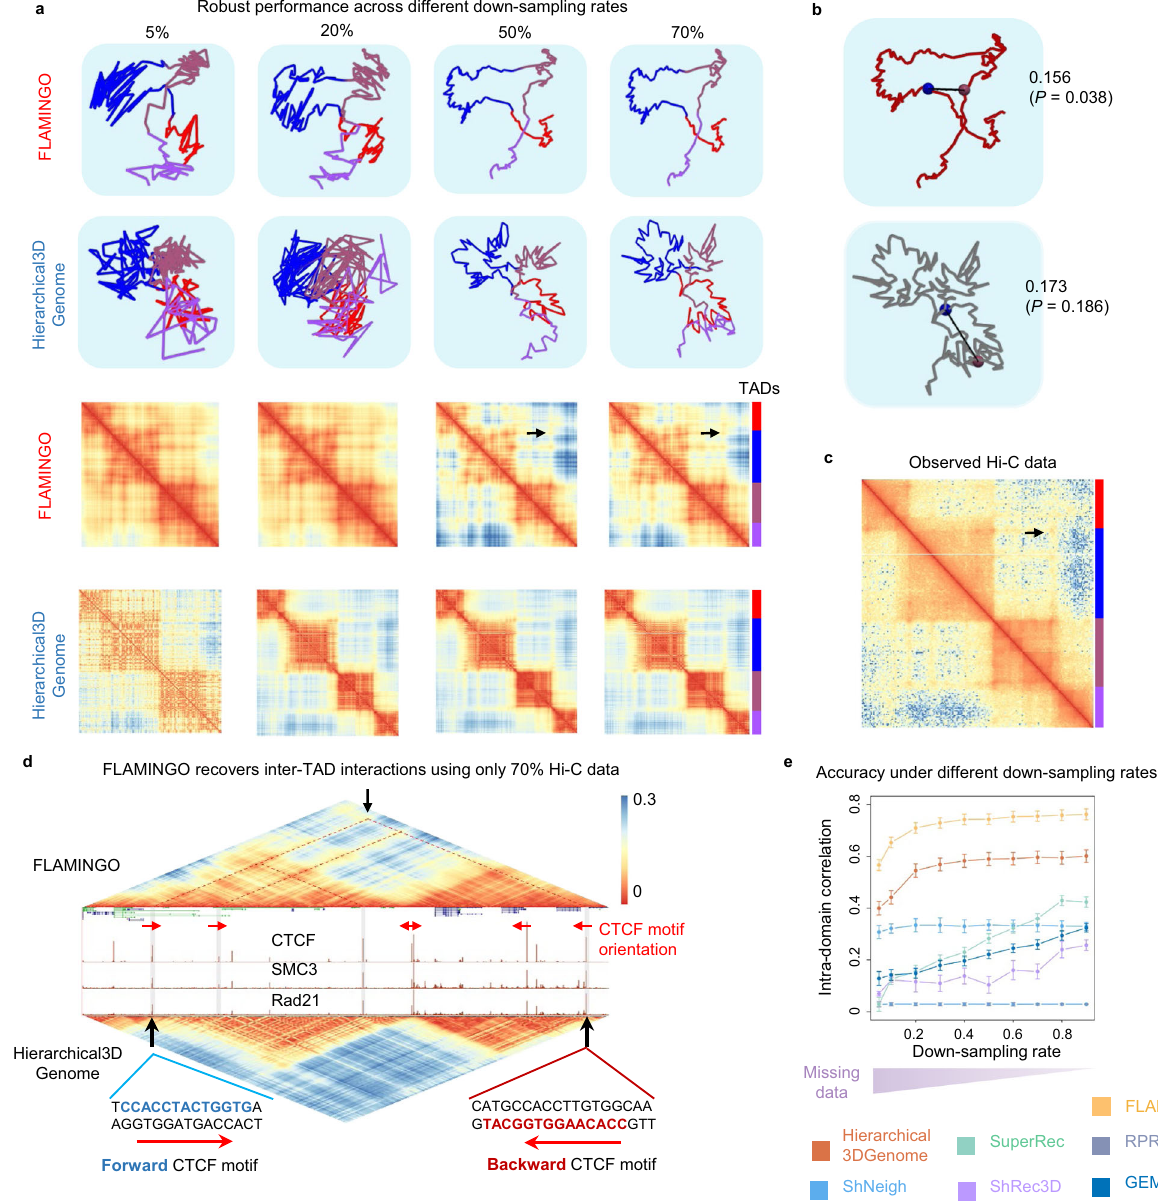
Fig. 6 FLAMINGO robustly reconstructs 3D genome structures under different rates of missing data. a Reconstructed 3D structures and completed distance matrices by FLAMINGO and Hierarchical3DGenome in chr21:34,000,000 – 35,000,000 using down-sampled data. As inputs, the observed distance matrix from Hi-C is down-sampled with different down-sampling rates (columns). Four TADs within this genomic region are annotated by colors. The inter- TAD interaction recovered only by FLAMINGO is highlighted by the black arrow. b FLAMINGO correctly recovers the short 3D distance between the two distal TAD boundaries (5 ’ of the blue TAD and 3 ’ of the brown TAD) as highlighted in a , with 70% down-sampled data. After normalization, FLAMINGO predicts a 3D distance of 0.156 ( p -value = 3.8×10 − 2 , n = 1000, permutation test, genomic distance controlled), while Hierarchical3DGenome predicts 0.173 ( p -value = 0.1862, n = 1000, permutation test, genomic distance controlled). c The observed distance matrix from Hi-C data, along with TAD annotations and the highlighted inter-TAD interaction. d The inter-TAD interactions recovered by FLAMINGO (zoom-in view of the blue and brown TADs within chr21:34,100,000 – 34,850,000) are supported by CTCF and cohesin bindings and the convergent CTCF motifs (red arrows). The inter-TAD interactions are missed by Hierarchical3DGenome. e FLAMINGO achieves higher reconstruction accuracy against missing data. Correlations between predicted and observed intra-domain structures (the y -axis) are calculated for FLAMINGO and the state-of-the-art methods under different down-sampling rates (the x -axis). The dots show the average correlations based on n = 10 independently down-sampled input matrices and error bars correspond to the standard deviations across the ten random samples. Smaller down-sampling rates represent larger fractions of missing data. Source data are provided as a Source Data fi (GM12878->K562). The 3D structure predicted based on K562 genome but also reconstructs detailed loop structures GM12878 Hi-C alone is shown as the negative control, and the structure predicted directly from K562 Hi-C is included as the positive control (Fig. 7a). The GM12878->K562 structure not only captures the global structural signatures of the